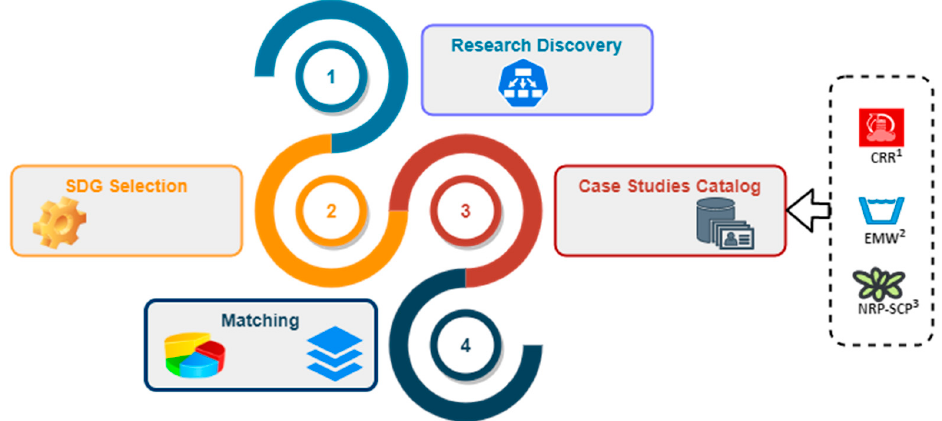
Figure 1. Research methodology framework. Notes: (1) CRR—Copernicus Risk Relay project; (2)